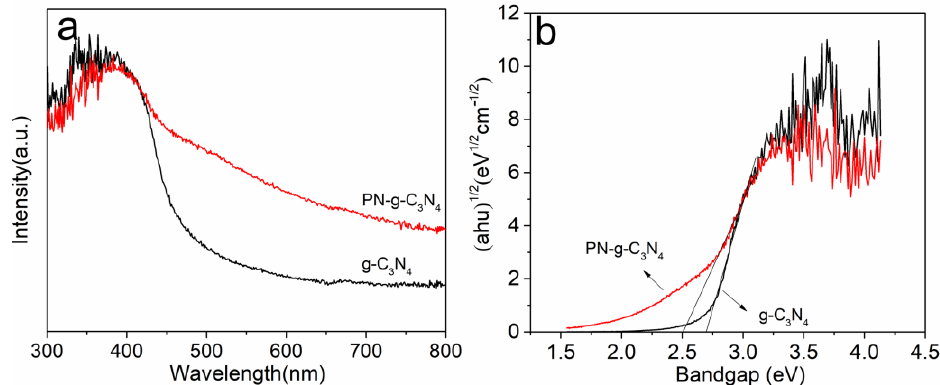
Figure 5. UV-Vis DRS ( a ) and band gaps ( b ) of g-C 3 N 4 and PN-g-C 3 N 4